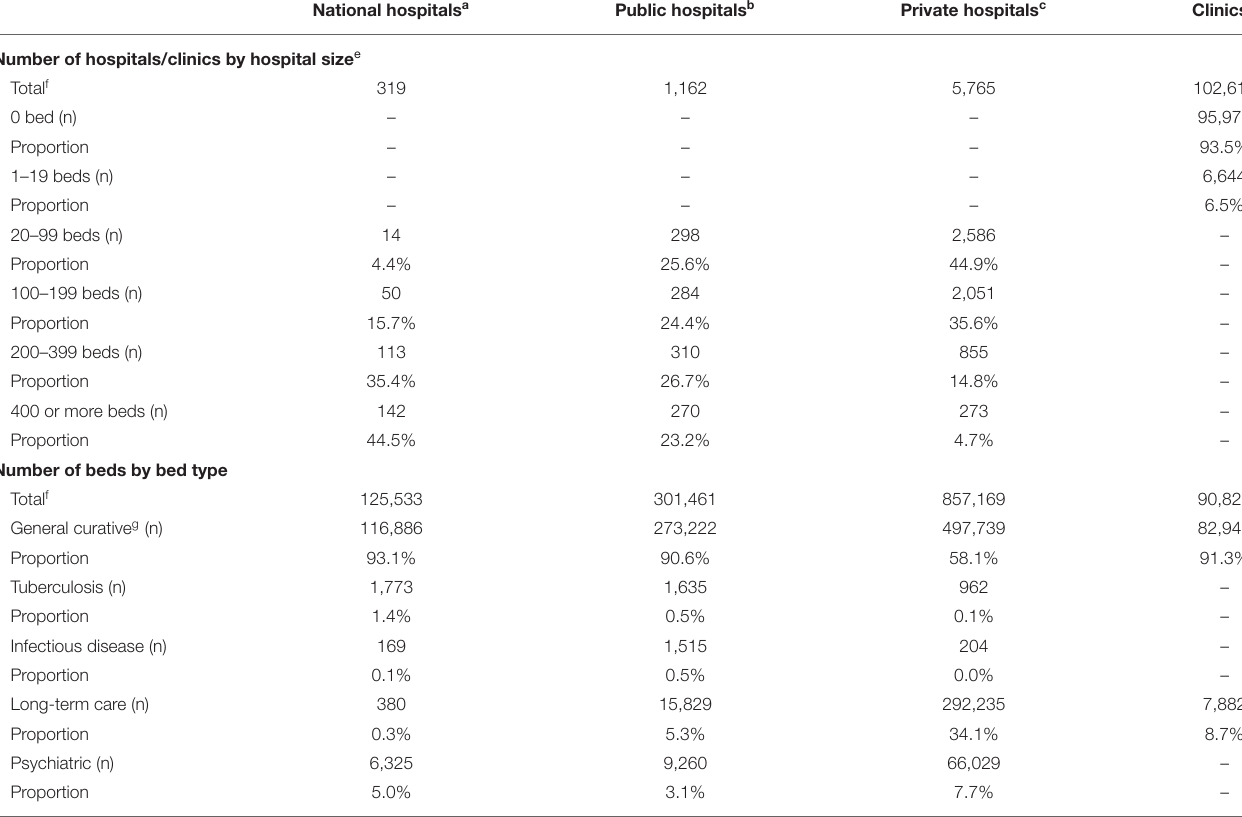
TABLE 2 | Size of medical care facilities and bed types by ownership in Japan